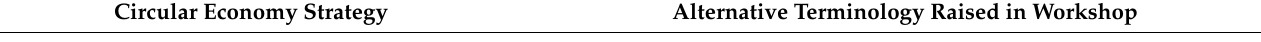
Table 2. Results from the workshop with the Offshore Renewable Energy Catapult in August 2020. Circular Economy